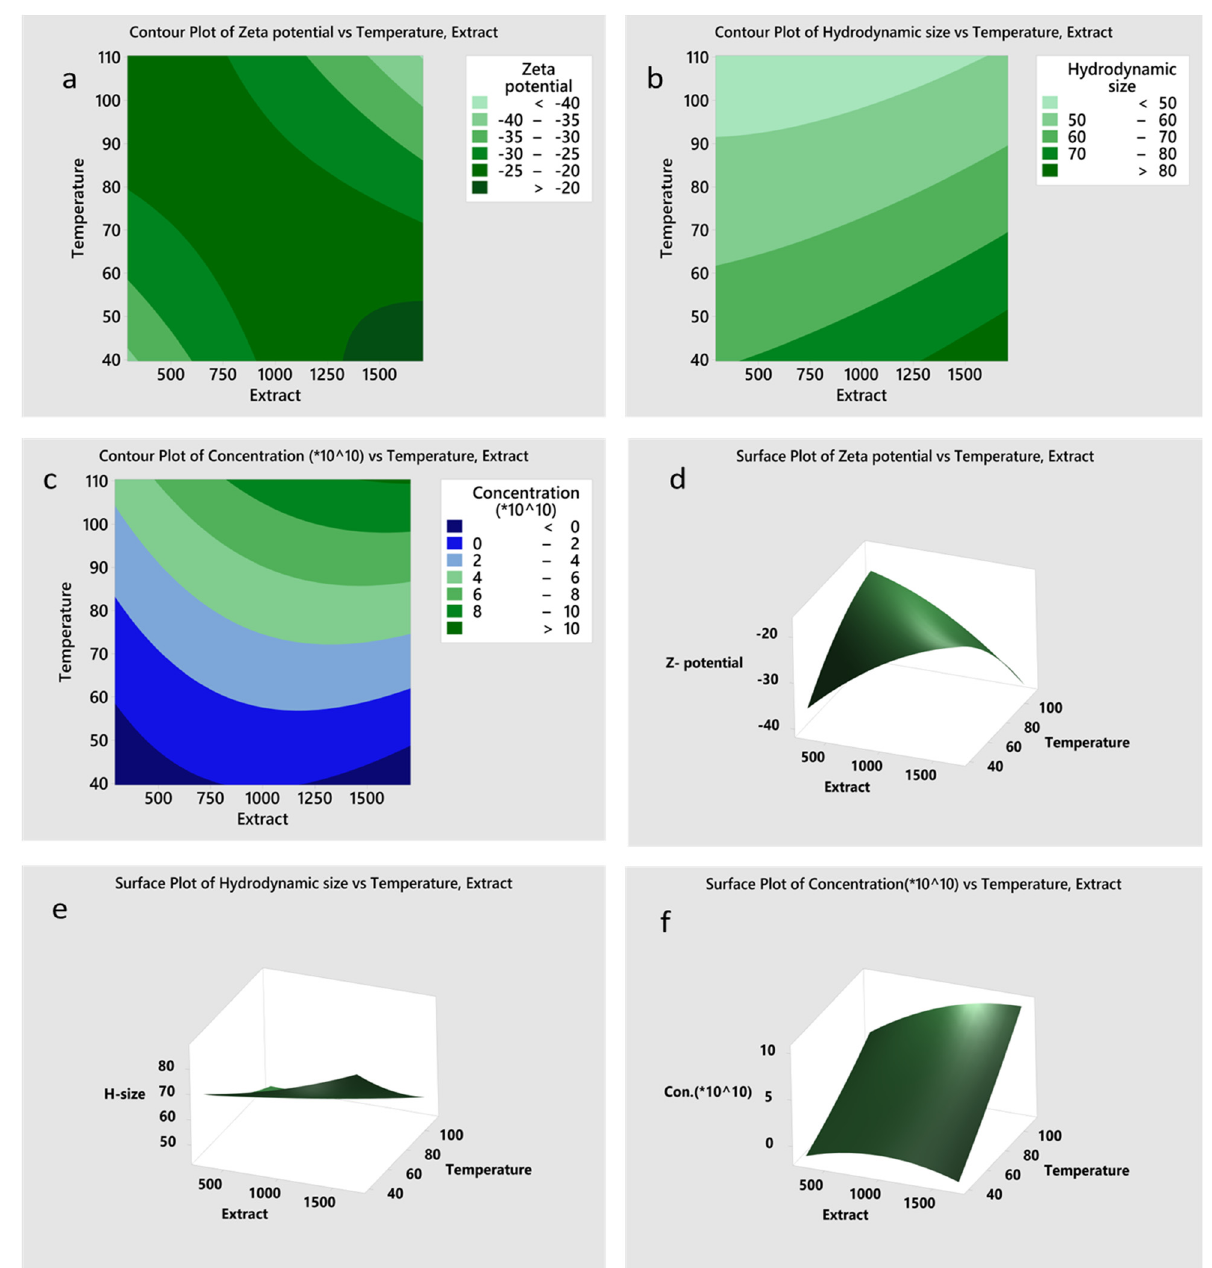
Figure 3. Contour plots ( a – c ) and 3D surface response plots ( d – f ) depicting the effects of volume of extract and temperature on zeta potential ( a , d ), hydrodynamic size ( b , e ), and nanoparticles synthesis ( c , f ). Table 3. Optimal condition prediction based on response surface model.